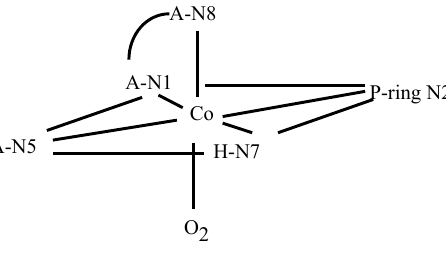
Figure 3. Coordination sphere of the Co(III) ion in Co(III)BLM proposed by Vos et al. [38].